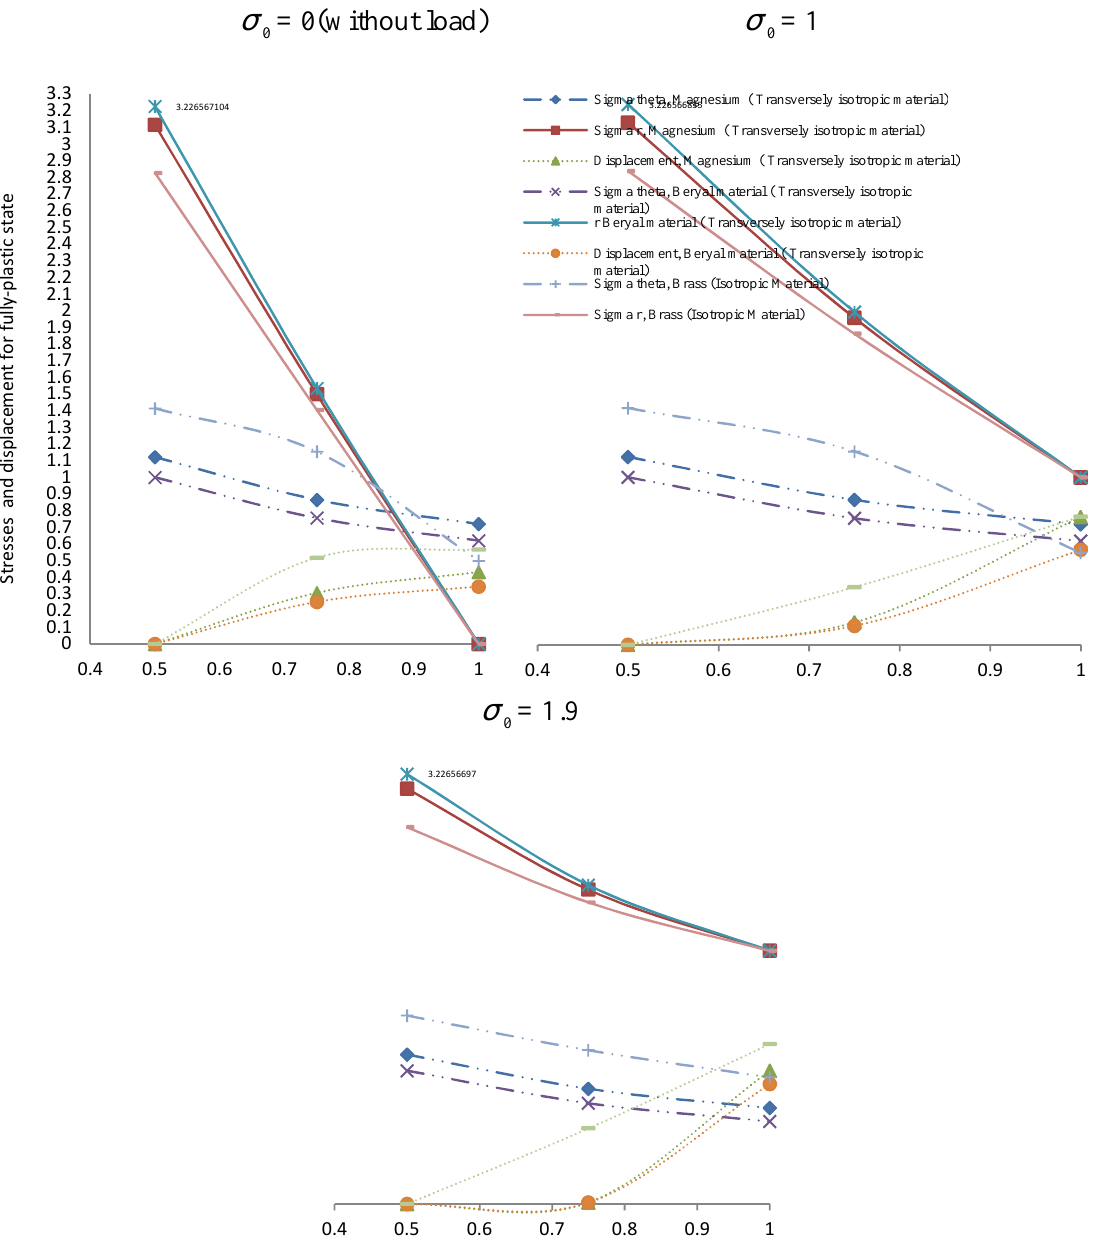
Figure 3. Stresses distribution and displacement for fully-plastic state along the radius ratio R =